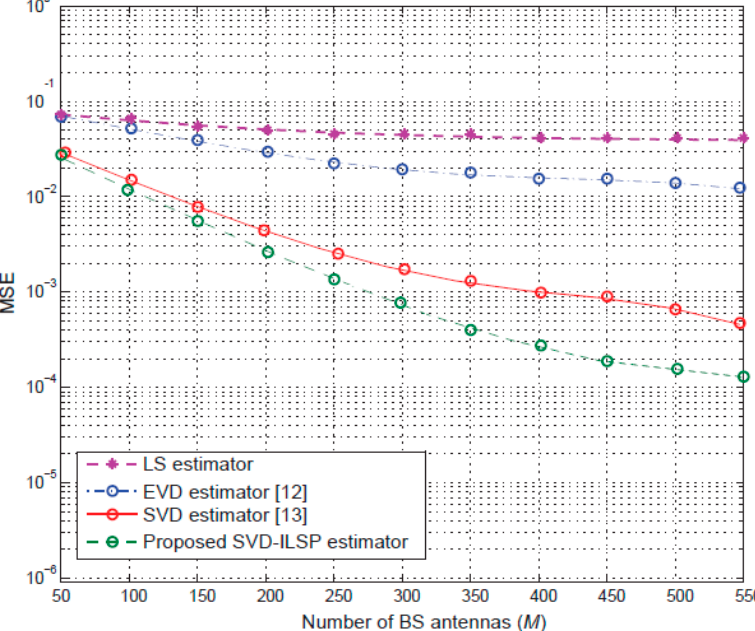
Figure 5. MSE comparison of algorithms under a different number of base station antennas.